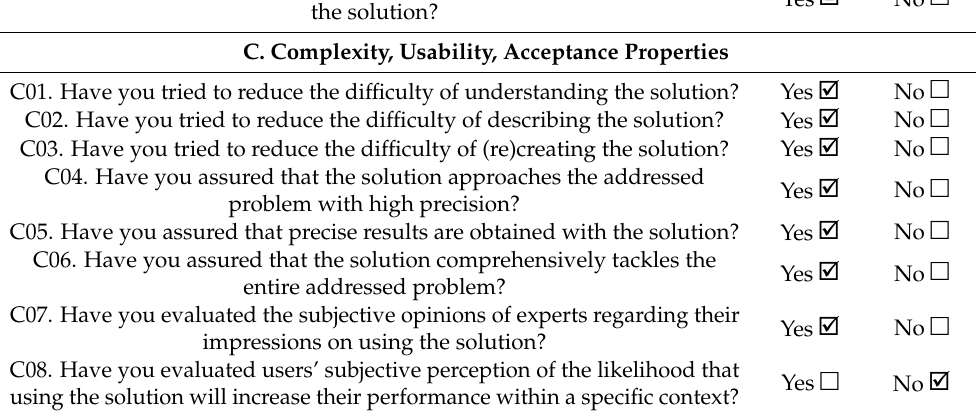
Table 1. Applicability control list. The symbol depicts a completely addressed control question. indicates an area that has been partially covered.